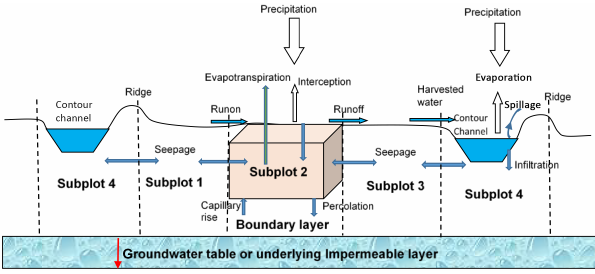
Figure 2. The hydrological system of a contour ridged